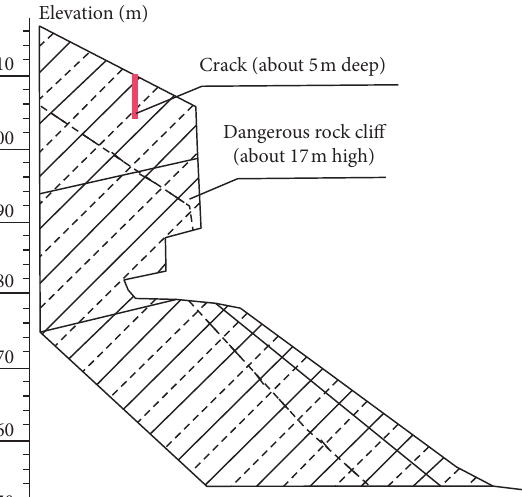
Figure 10: Falling-type dangerous rock mass of W 6.